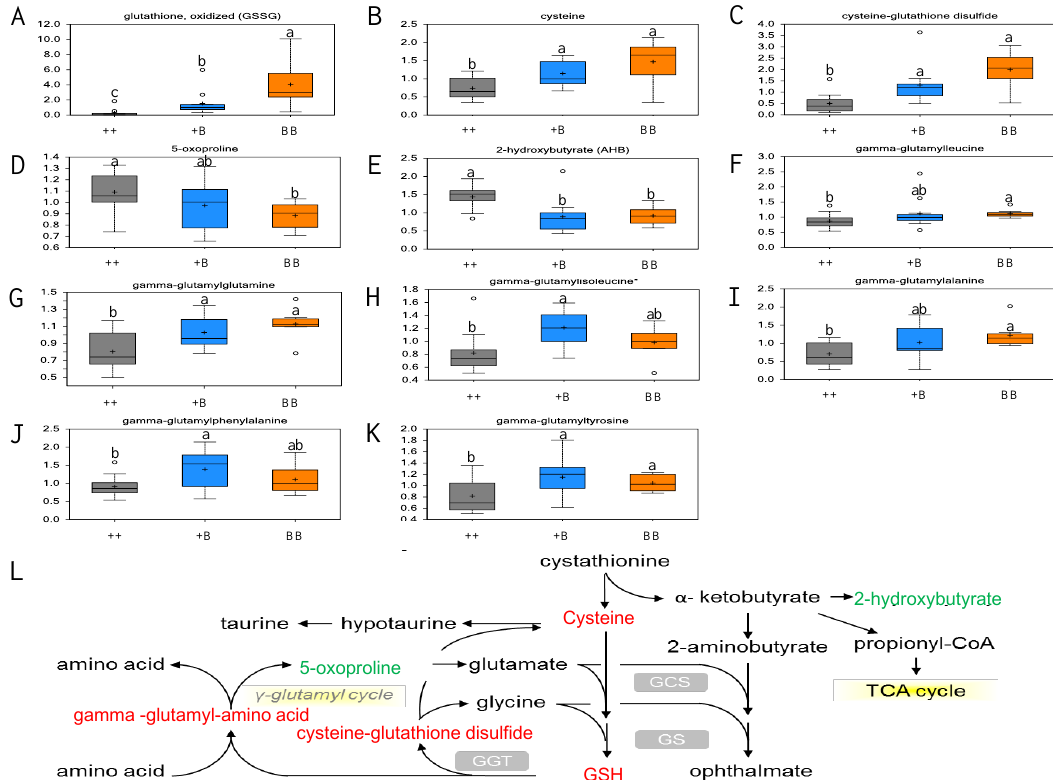
Figure 5 Elevation of antioxidant defense capacity in FF Figure 5. Elevation of antioxidant defense capacity in FF. Note: a, b, c represent means with different Note: Box plots with same superscript indicats no significant difference, box plots with different superscript indicate differ significantly ； red font indicates the concentration of biochemical elevated in BB with significant difference (P≤0.05), green font indicates the superscripts in box plots have a significant difference ( p ≤ 0.05); box plots with ab superscript indicate concentration of biochemical declined in BB with significant difference (P≤0.05). no significant difference with a and b; red font indicates that the concentration of biochemicals was elevated in BB with a significant difference ( p ≤ 0.05), and the green font indicates that the concentration of biochemicals declined in BB with a significant difference ( p ≤ 0.05). ( A ) Box plots for glutathione, oxidized (GSSG) in FF samples; ( B ) Box plots for cysteine in FF samples; ( C ) Box plots for cysteine-glutathione disulfide in FF samples; ( D ) Box plots for 5-oxoproline in FF samples; ( E ) Box plots for 2-hydroxybutyrate in FF samples; ( F ) Box plots for γ -glutamylleucine in FF samples; ( G ) Box plots for gamma-glutamylglutamine in FF samples; ( H ) Box plots for gamma-glutamylisoleucine in FF samples; ( I ) Box plots for gamma-glutamylalanine in FF samples; ( J ) Box plots for γ -glutamylphenylalanine in FF samples; ( K ) Box plots for gamma-glutamyltyrosine in FF samples; ( L ) The biological synthesis of GSH (glutathione). Table 3. Levels of biochemicals related to antioxidant defense capacity comparing in FF. Biochemical Name